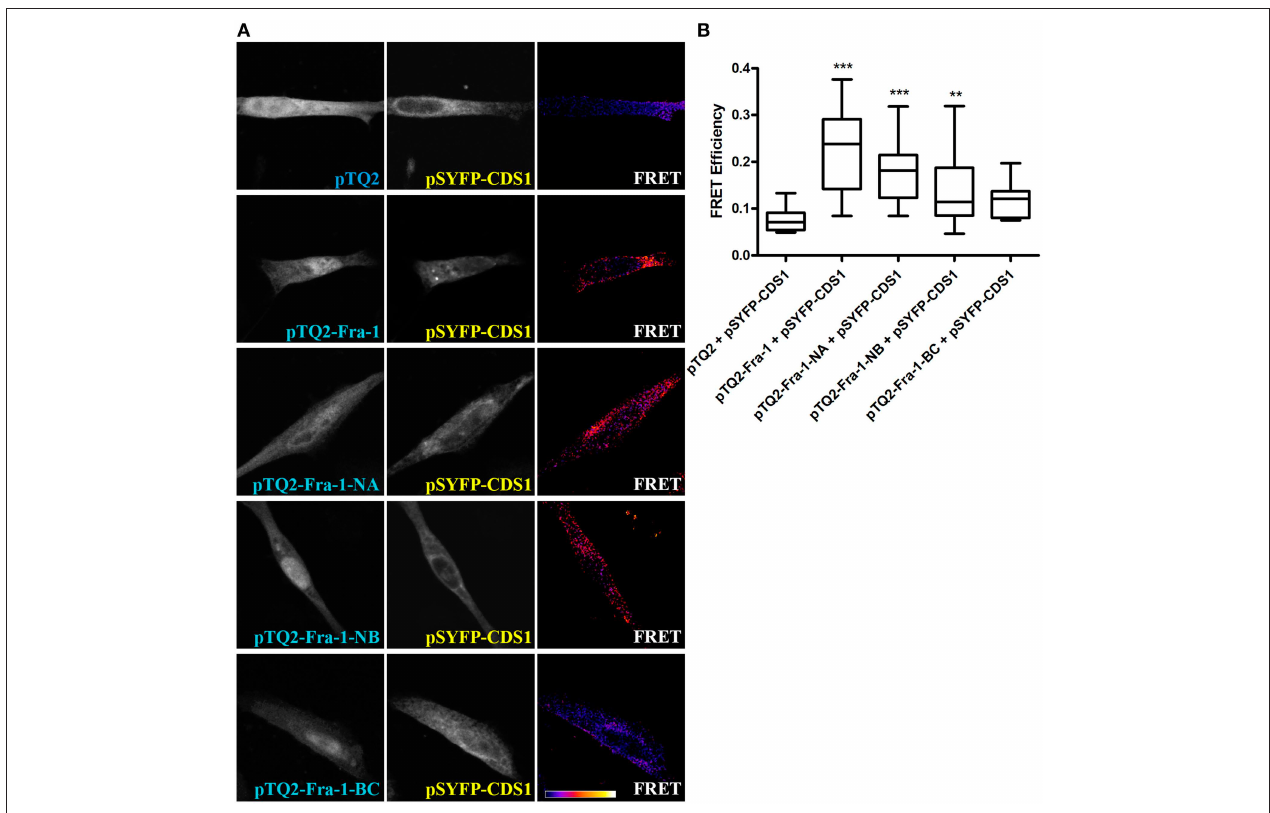
FIGURE 3 | The N-terminus domain of Fra-1 physically associates with CDS1. (A) MDA-MB231 cells were co-transfected to express the negative control pTQ2 and pSYFP-CDS1 (first row), pTQ2-Fra-1 and pSYFP-CDS1 (second row), pTQ2-Fra-1-NA and pSYFP-CDS1 (third row), pTQ2-Fra-1-NB and pSYFP-CDS1 (fourth row) or pTQ2-Fra-1-BC and pSYFP-CDS1 (last row), and were examined by confocal microscopy. FRET quantification was performed by the sensitized emission method. The first column shows the expression of tagged Fra-1 or of its deletion mutants, the second of the tagged enzyme and the third column shows FRET efficiency. The scale bar on the bottom row of the right column shows an increasing FRET efficiency scale from violet (negative) to white (maximum). (B) FRET efficiency quantification depicted as boxplot graphs representing the medians (central horizontal bars), the 25–75th percentile interquartile range (box limits), and the lowest and highest values (whiskers). ** p < 0.01; *** p < 0.001 (Kruskal-Wallis test, Dunn’s post-test). One representative experiment of three performed, which gave essentially the same results, is